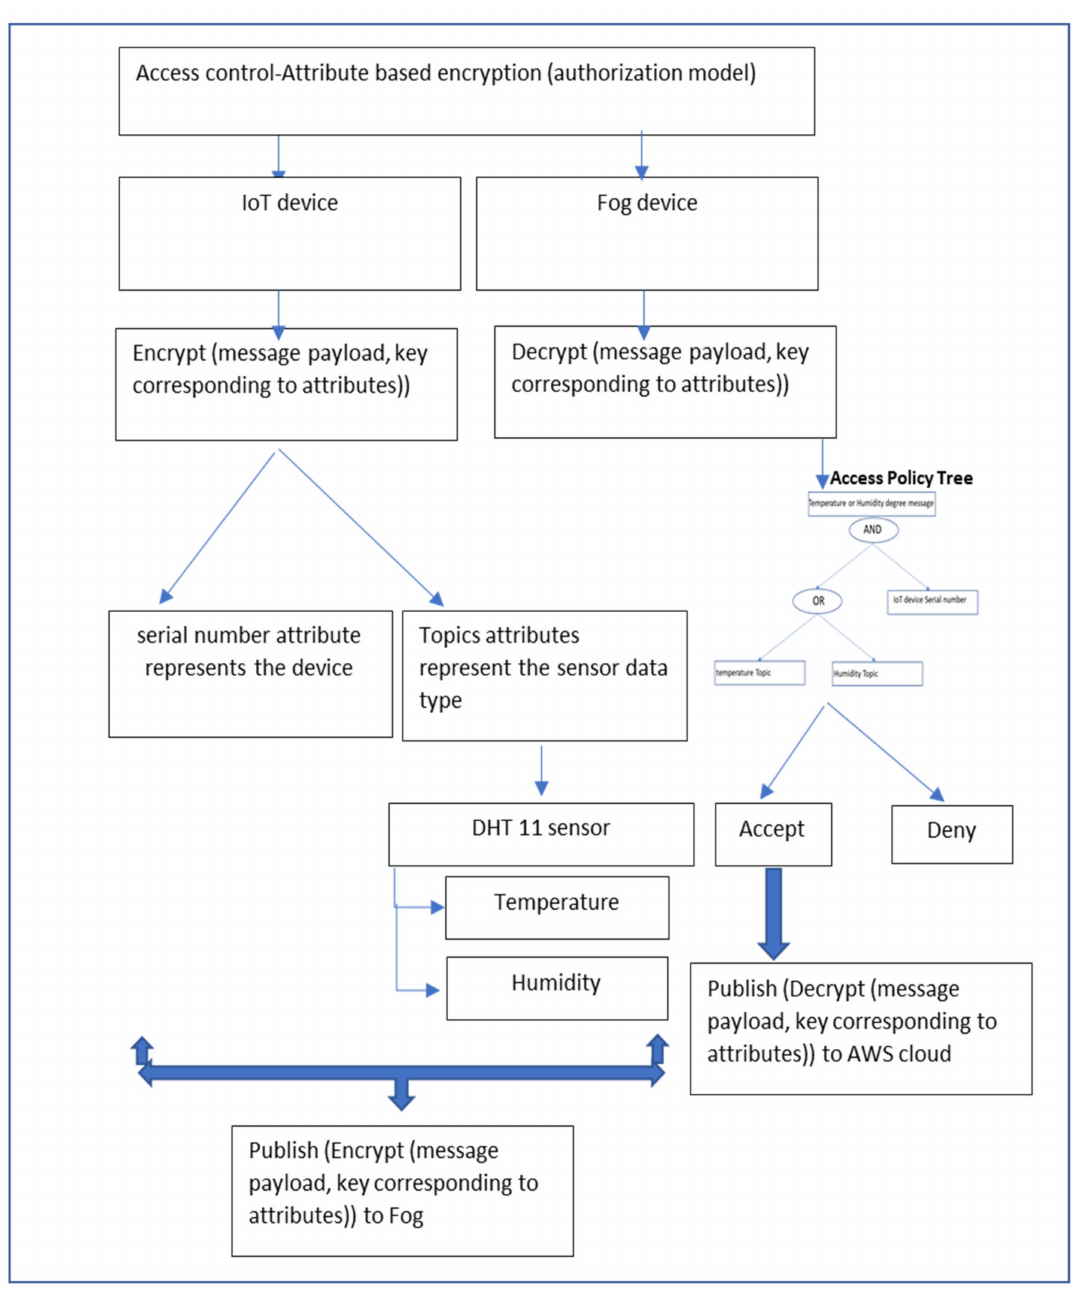
Figure 3. Access control model for the IoT–Fog–Cloud architecture. The fog device then generates an access policy tree according to the attributes of each data type in the IoT device, an example of which is presented in Figure 4. Once the fog device receives the ciphertext from the IoT device, it decrypts it if the ciphertext key that contains the attributes satisfies the access policy tree. Otherwise, it will decline the decryption request. Then, the temperature degree value will be published to the AWS cloud. Figure 5 shows how the ABE for the access control model was applied to the IoT–Fog–Cloud